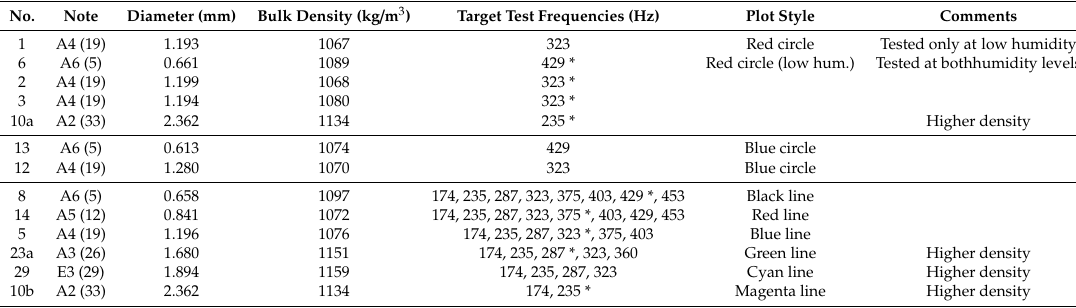
Table 1. The set of nylon harp strings studied, showing the unstretched string parameters, the target fundamental frequencies for testing and the plot styles used in the responses shown in the figures. The number in the first column provides a unique reference for each test string or string